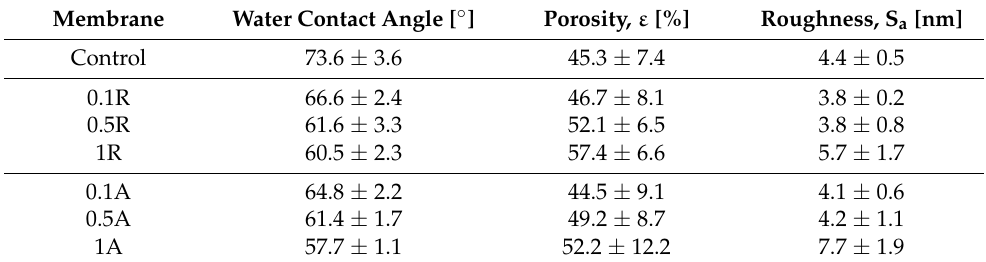
Table 4. Water contact angle, porosity, and roughness of the studied membranes. Membrane Water Contact Angle [ ◦ ] Porosity, ε